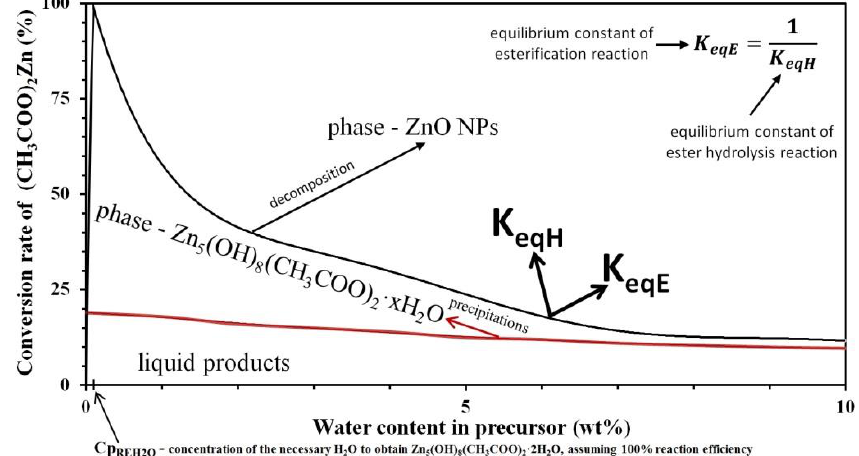
Figure 52. A reference phase diagram for the course of the ZnO NPs synthesis reaction, taking into account H 2 O content loss caused by zinc acetate hydrolysis. Republished with permission of ©